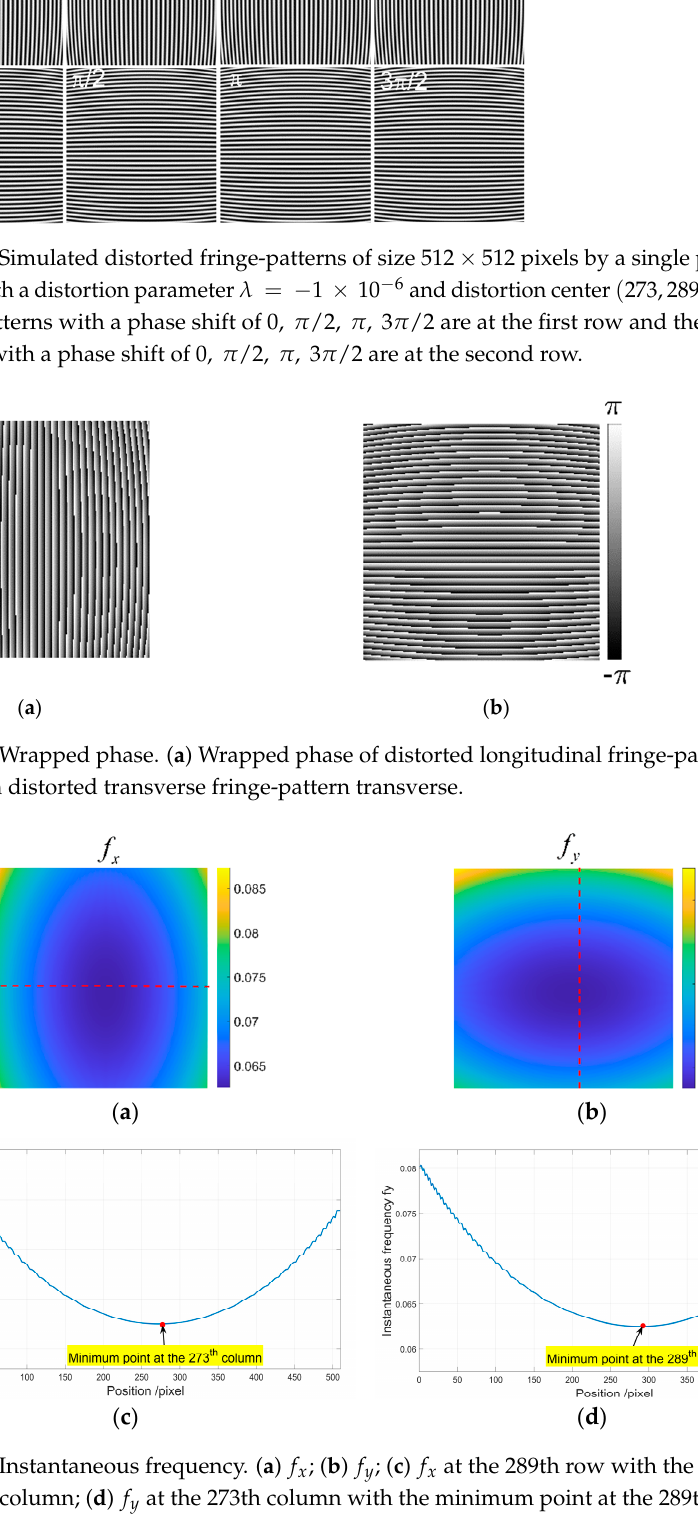
f ; ( b ) f at the 289th row with the minimum point f ; ( c ) Figure 5. Instantaneous frequency. ( a ) Figure 5. Instantaneous frequency. ( a ) f x ; ( b ) f y ; ( c ) f x at the 289th row with the minimum point at x x y f at the 273th column with the minimum point at the 289th row. at the 173th column; ( d ) the 173th column; ( d ) f y at the 273th column with the minimum point at the 289th y Step3: Modulated phase calculation. According to Equation (8), the modulated phase ( , ) x y ϕΔ and ( , ) x y ϕΔ are obtained as shown in Figure 6a,b. So, the distortion dis- x y placement ( , ) x x y Δ and ( , ) y x y Δ are obtained point by point according to Equation (9), as shown in Figure 6c,d. The distortion displacement ( d ) Figure 6. Modulated phase and distortion displacement. ( a )